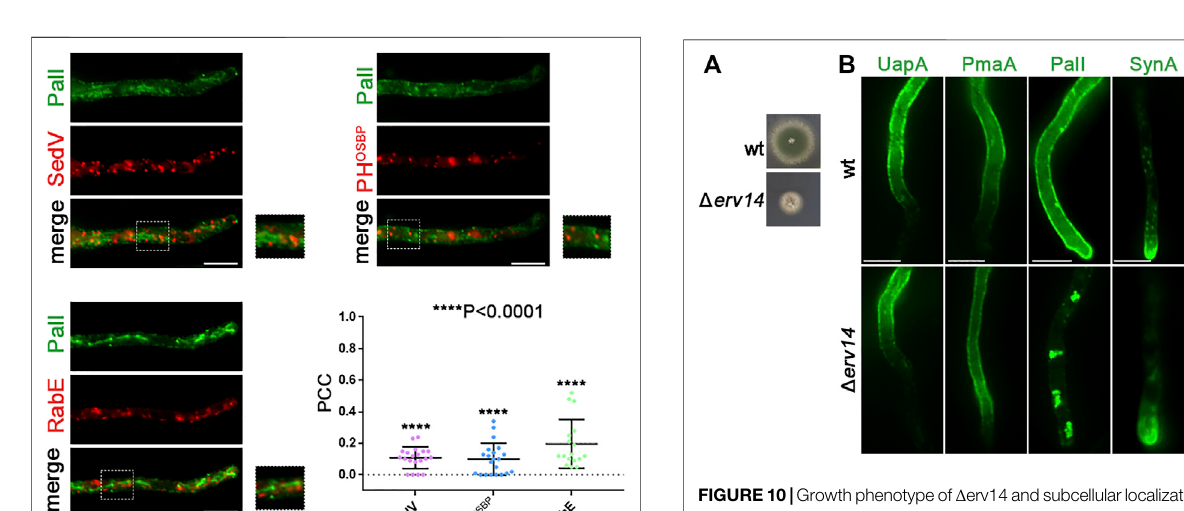
FIGURE10| Growthphenotypeof Δ erv14andsubcellularlocalizationof UapA, PmaA, PalI, SynA, and ChsB in Δ erv14. (A) Colony growth of Δ erv14 compared to an isogenic wild-type control strain (wt). (B) Epi fl uorescence microscopic analysis of non-polar and polar cargoes in conditions of Erv14 depletion (lower panel). It is noted that the lack of Erv14 does not affect the localization of UapA, PmaA, SynA, and ChsB, but leads to the retention of PalI in cytosolic aggregates. Scale bars: 5 μ